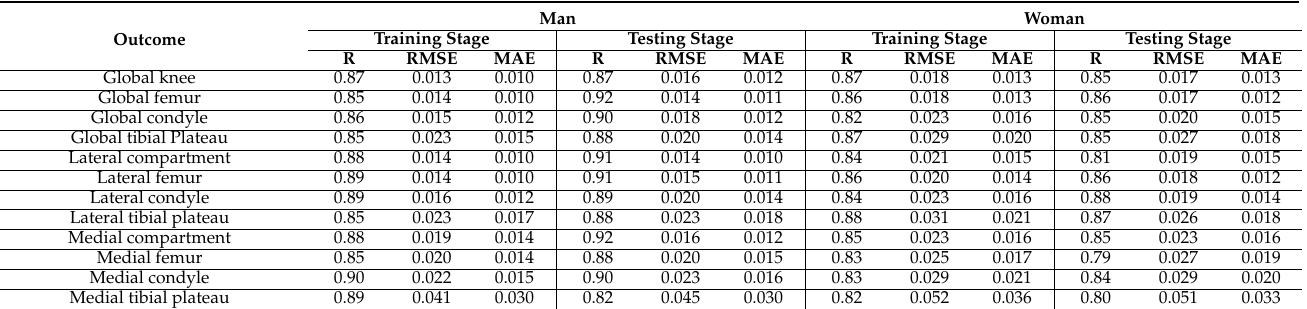
Table 9. Performance of prediction of cartilage volume loss at one year in 12 cartilage regions using five bone curvature regions at the baseline.